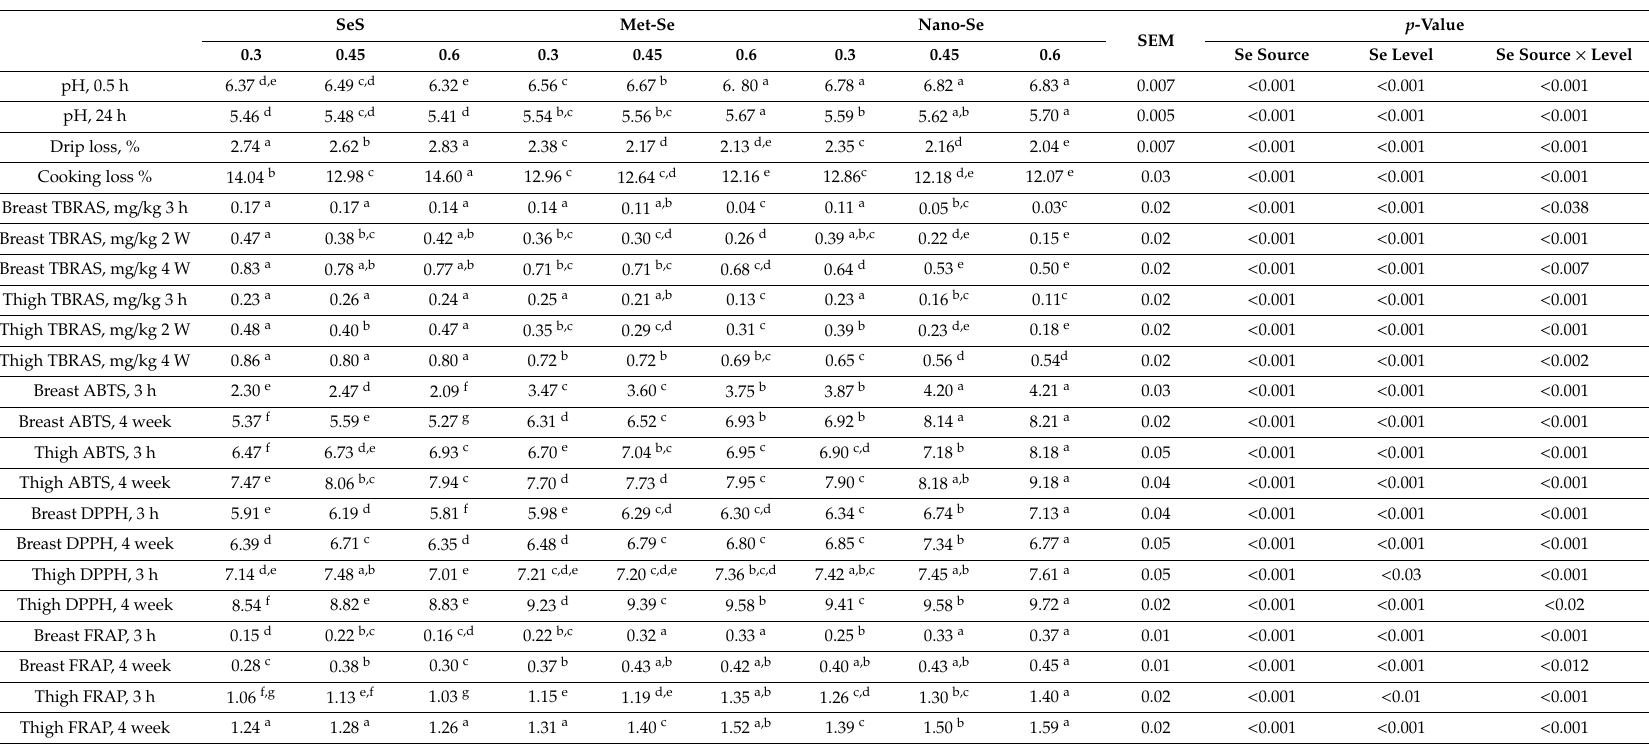
Table 4. E ff ects of dietary Se source and level (mg / kg) on meat quality after slaughter and antioxidative potential of broiler meat (breast and thigh) during frozen storage. SeS